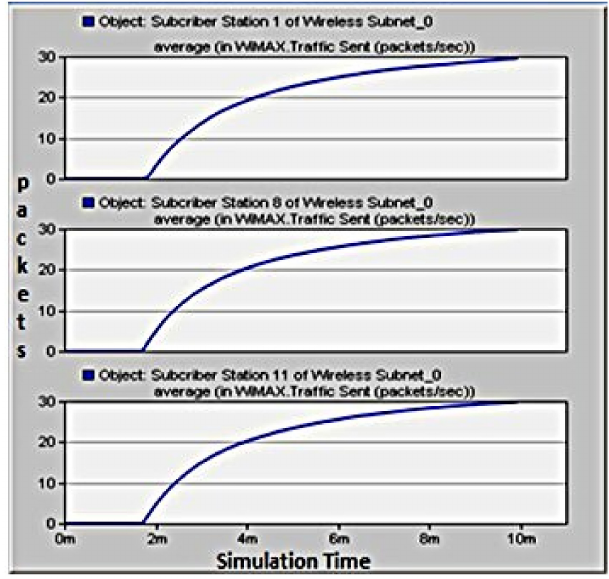
Figure 3. The initial traffic sent.